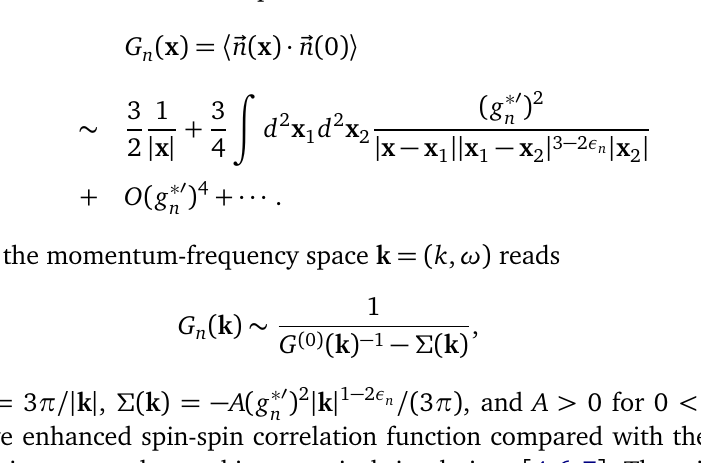
is nonzero, both v